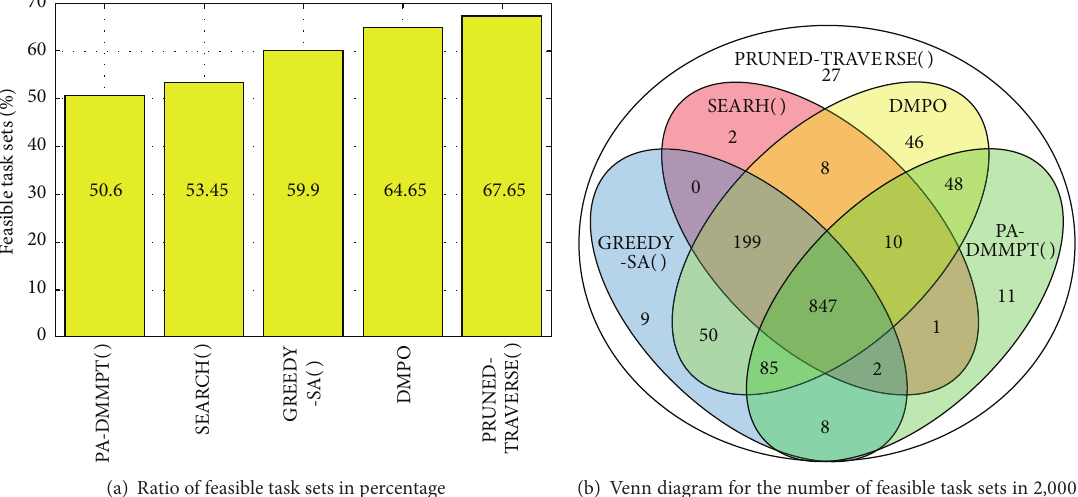
Figure 3: Schedulability with 𝑈 = 0.9 and |Γ| = 10 .